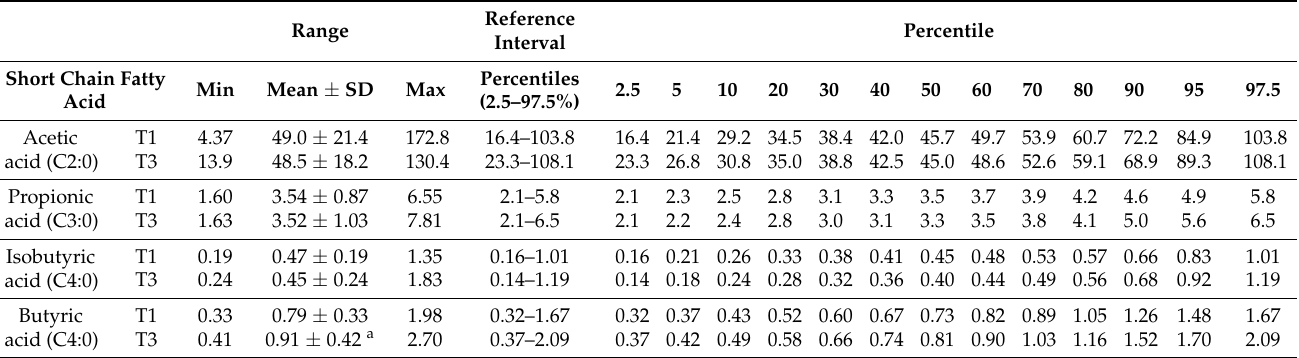
Table 2. Range, mean, and percentile distribution of maternal short chain fatty acid serum concentra- tion ( µ mol/L) during pregnancy period.